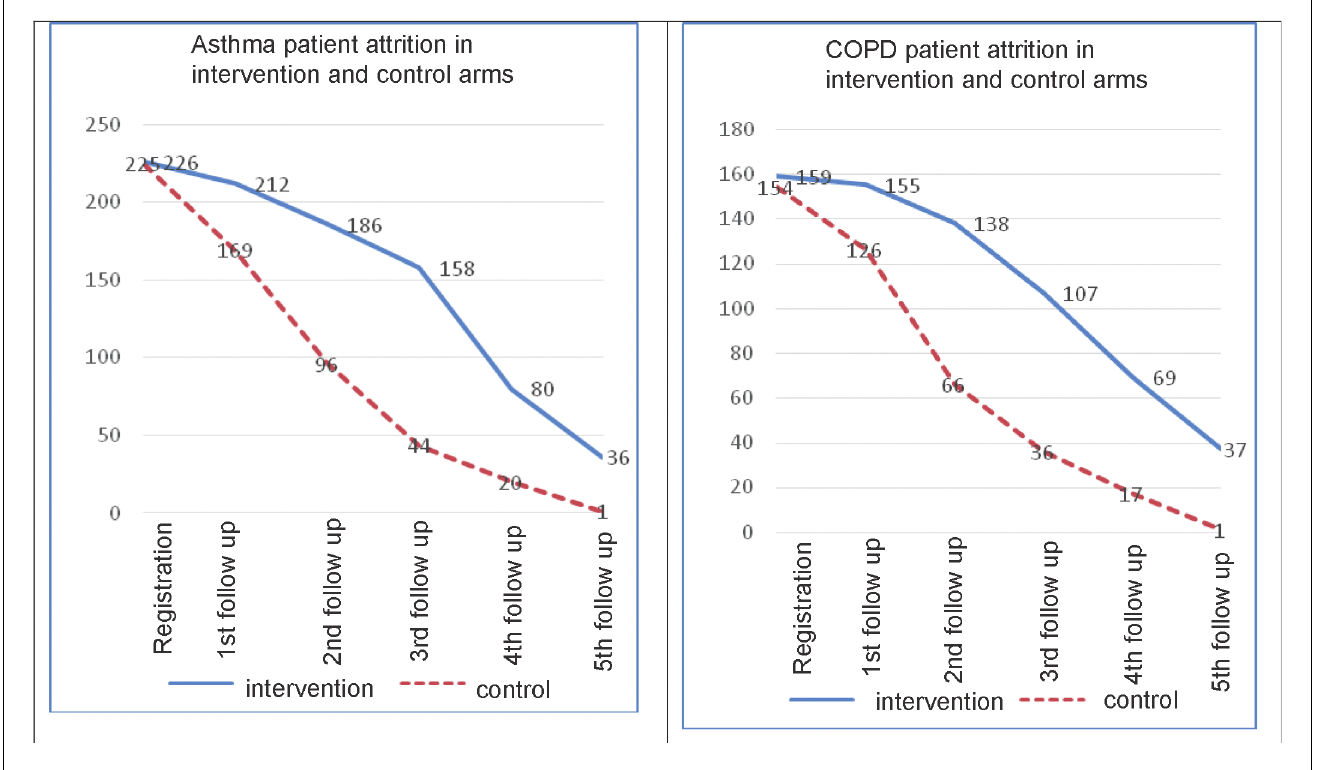
Figure 2. Asthma and COPD patient attrition in intervention and control arms COPD = chronic obstructive pulmonary disease.